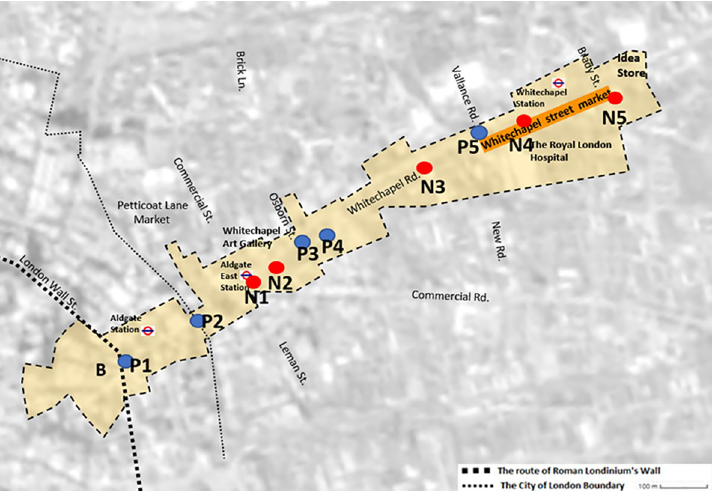
Fig 2. Whitechapel Rd: (1) Just outside the Roman Eald Gate and today’s Aldgate; (2) The border between the City of London and the London Borough of Tower Hamlets; (3) East Aldgate station; (4) Main junction of Commercial Rd and Whitechapel Rd; (5) Osborn St, the way to Brick Ln and Shoreditch; (6) Atlab Ali park; (7) The East London Mosque & London Muslim Centre; (8) The beginning of Whitechapel market; (9) Whitechapel train station for underground & overground; (10) Idea store and the end of Whitechapel market. Note that this figure presents the longitudinal axis of Whitechapel Rd. To highlight the gathering points within their surroundings, Fig 2 was limited to include only the entire buildings adjusted to the street-front or those connected through a common yard or function. For example, the hospital has eight adjoining buildings, the area around Whitechapel tube station, East London mosque and the gallery (https://eoimages.gsfc.nasa.gov/images/imagerecords/78000/78669/london_etm_2002256_ 321_lrg.jpg).